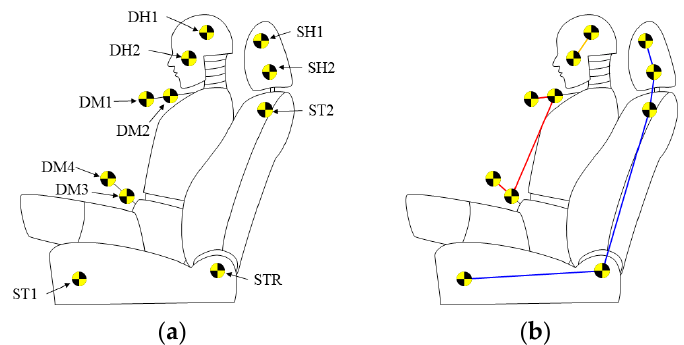
Figure 4. Markers on the seat and dummy: ( a ) before sled test; ( b ) after sled test.